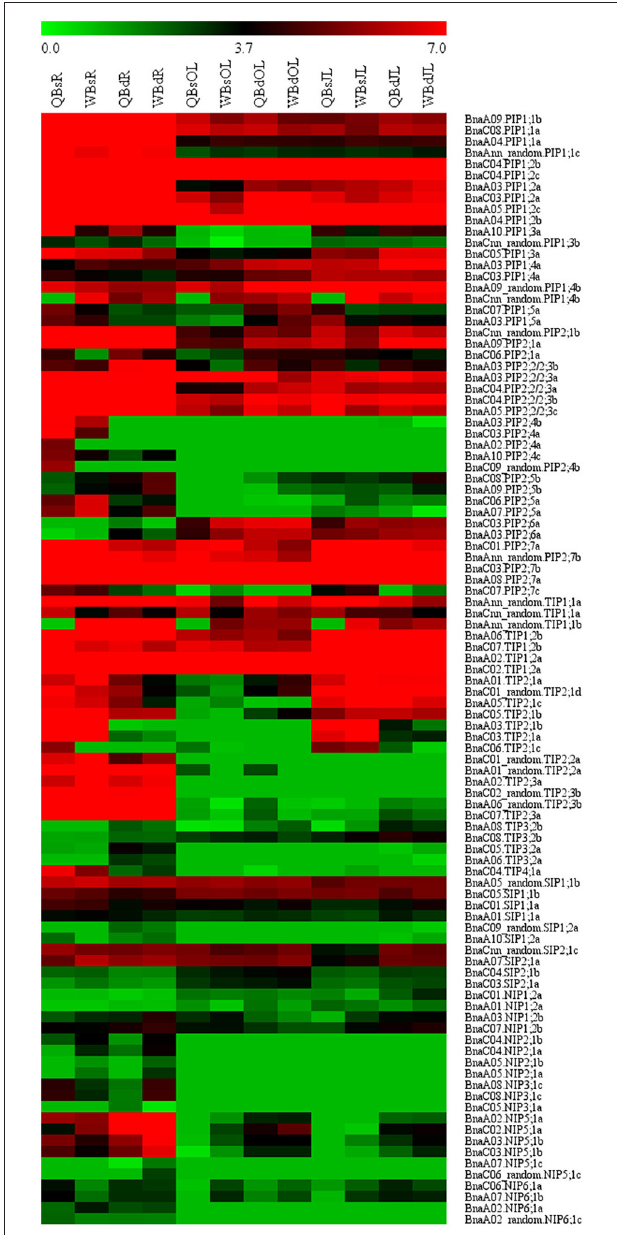
FIGURE 5 | Expression profile of BnaAQP s in response to low boron stress in Brassica napus . The RPKM (reads per kilo bases per million reads) values of 99 BnaAQP s (non-expressed genes were not included) were obtained from the RNA-seq data, and then the RPKM values were converted into the logarithmic values. The heat map of expression profile of BnaAQP s in roots (R), old leaves (OL), and juvenile leaves (JL) was generated using the MeV program. The two cultivars of Brassica napus , QY10 (Q, B-efficient), and W10 (W, B-inefficient), were cultured in hydroponic solution with B deficient conditions (d, 0.25 µ M) and B sufficient conditions (s, 25 µ M) for 30